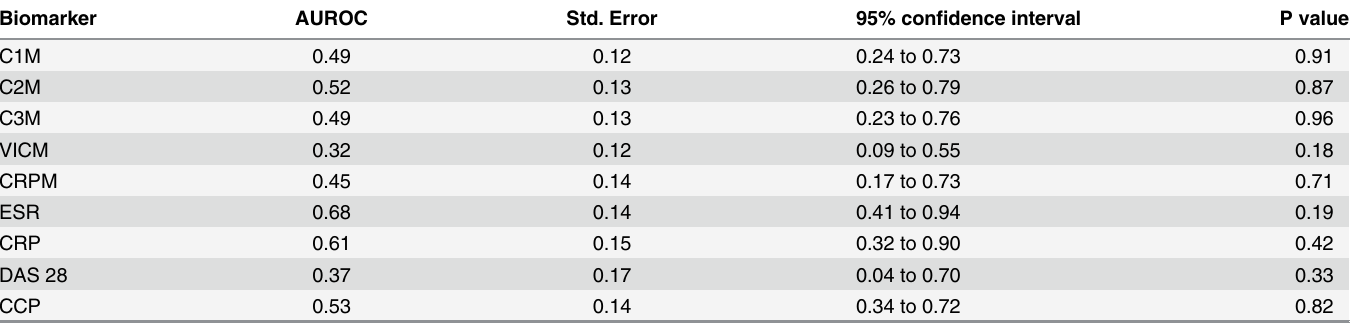
Table 3. Area under the receiver operating characteristic (AUROC) for discriminating between UA patients that progress to RA after 2 years of fol- low-up and those that remain UA after 2 years of follow-up.